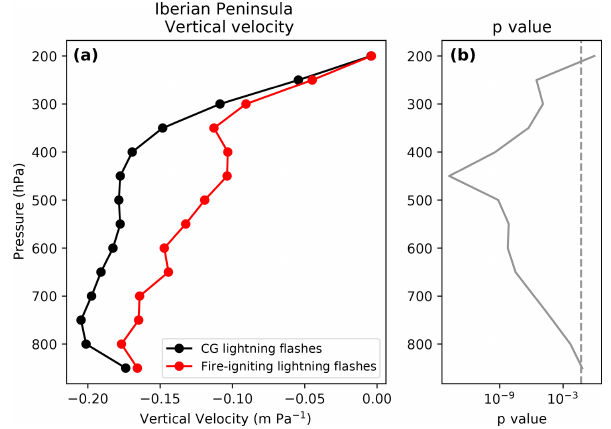
Figure 10. Median vertical velocity profile for the CG lightning and the fire-igniting lightning climatologies in the Iberian Peninsula between May and September for the period between 2009 and 2015 (a) . The p value (solid line), representing the probability of equal median between both distributions, and the mark showing the limit at 0.05 (dashed line) are shown (b) .